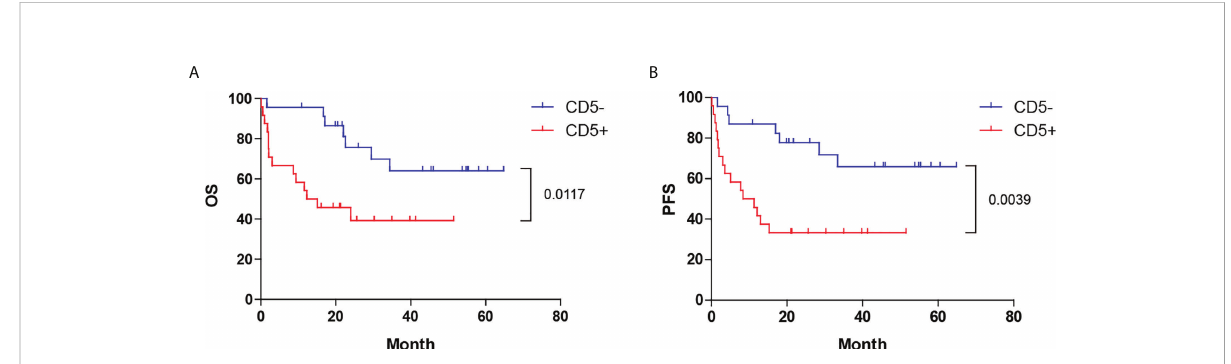
FIGURE 1 Distinct prognoses between CD5+ and CD5- DLBCL. Kaplan – Meier plot of (A) OS and (B) PFS between CD5+ and CD5- cases. OS, overall survival; PFS, progression-free